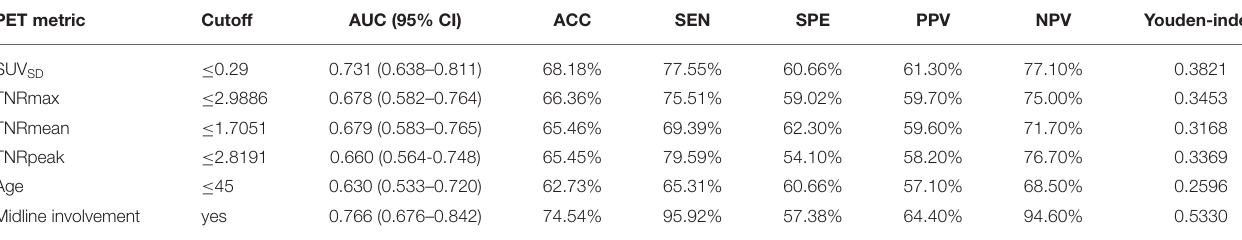
TABLE 4 | The Performance of 11 C-MET PET metrics and age feature for IDH-mutation prediction.